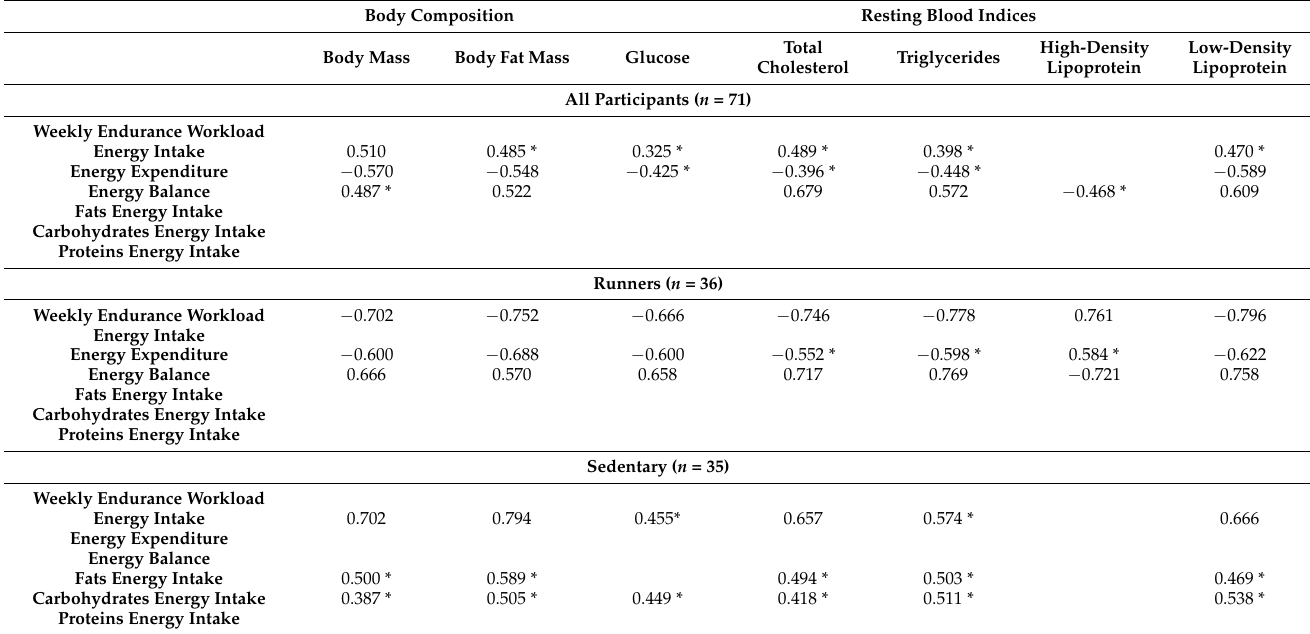
Table 2. Correlations (Pearson’s r) between body, fat masses, blood glucose, total cholesterol, triglyc- erides, High-density lipoprotein (HDL-C), Low-density lipoprotein and weekly endurance training workload, energy balance and macronutrients intake. Only the significant correlations are presented. Body Composition Resting Blood Indices Body Mass Body Fat Mass Glucose Total Cholesterol Triglycerides High-Density Lipoprotein Low-Density Lipoprotein All Participants ( n =